Question: In a single sentence, describe what this figure presents.
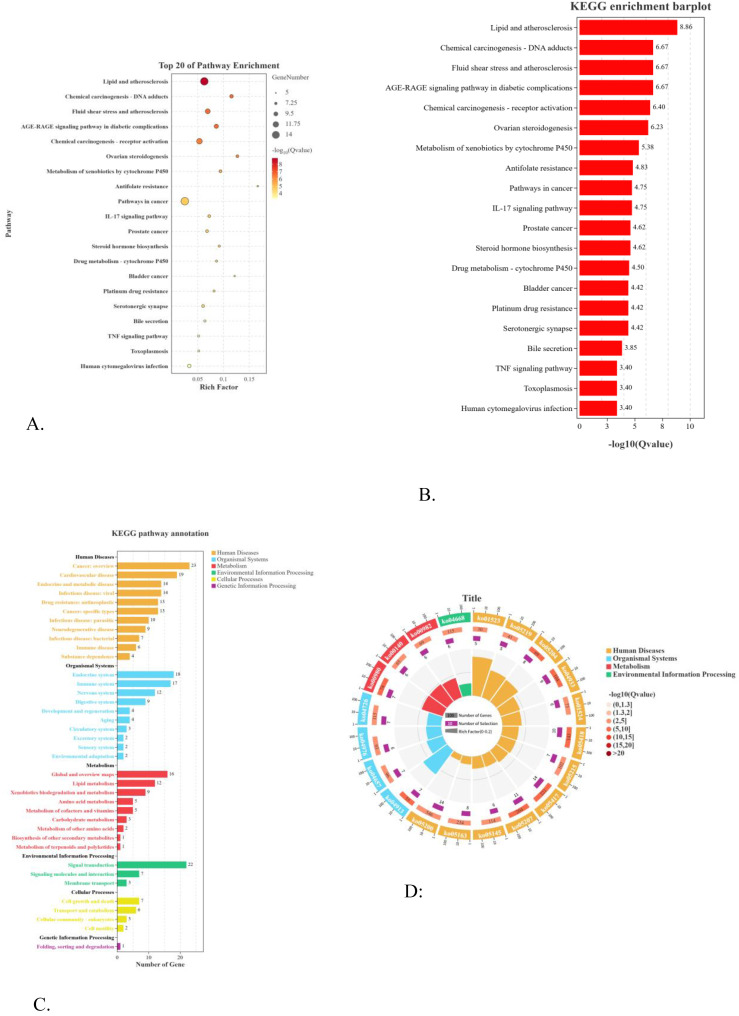
Answer: Visualization of the KEGG signaling pathway (Tufuling). (A) KEGG significance bubble plot. (B) KEGG significance histogram. (C) KEGG number statistic graph. (D) KEGG enrichment circle diagram.